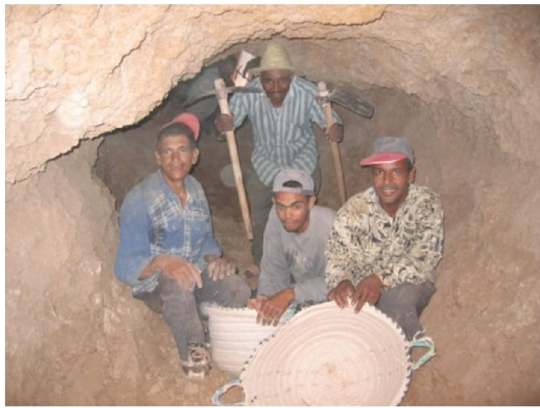
Fig. 5 Photo of khettaters, builders of khettaras (Source: the authors)